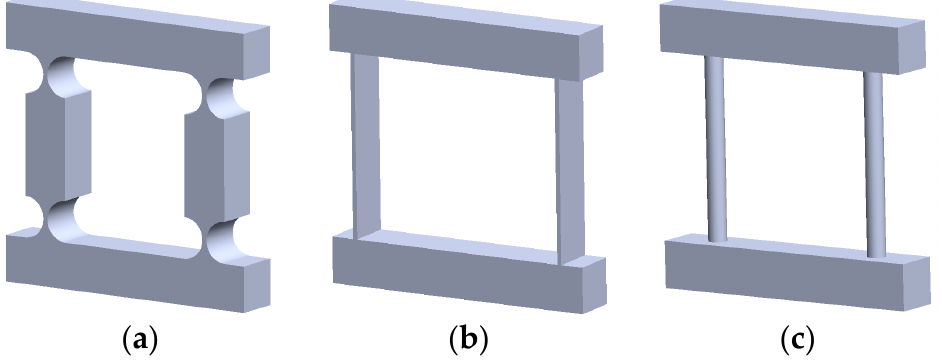
Figure 2. Types of compliant mechanisms with basic flexure hinges: ( a ) notch flexure hinges, ( b ) leaf springs joints, and ( c ) rod-shaped joints.